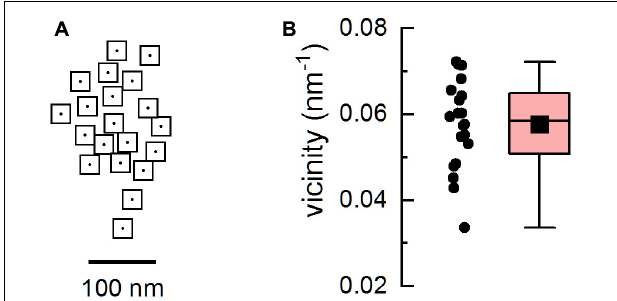
FIGURE 1 | The geometric model of the calcium release site. (A) The arrangement of ryanodine receptors (RyRs) in the model CRS. The empty squares with dots represent RyRs with a central ion channel, the gated point source of Ca2+ current. (B) The distribution of RyR vicinities in the model CRS. The box diagram shows the 25% and 75% percentile, whiskers show minimum and maximum, the black square depicts the mean, and the horizontal line represents the median.